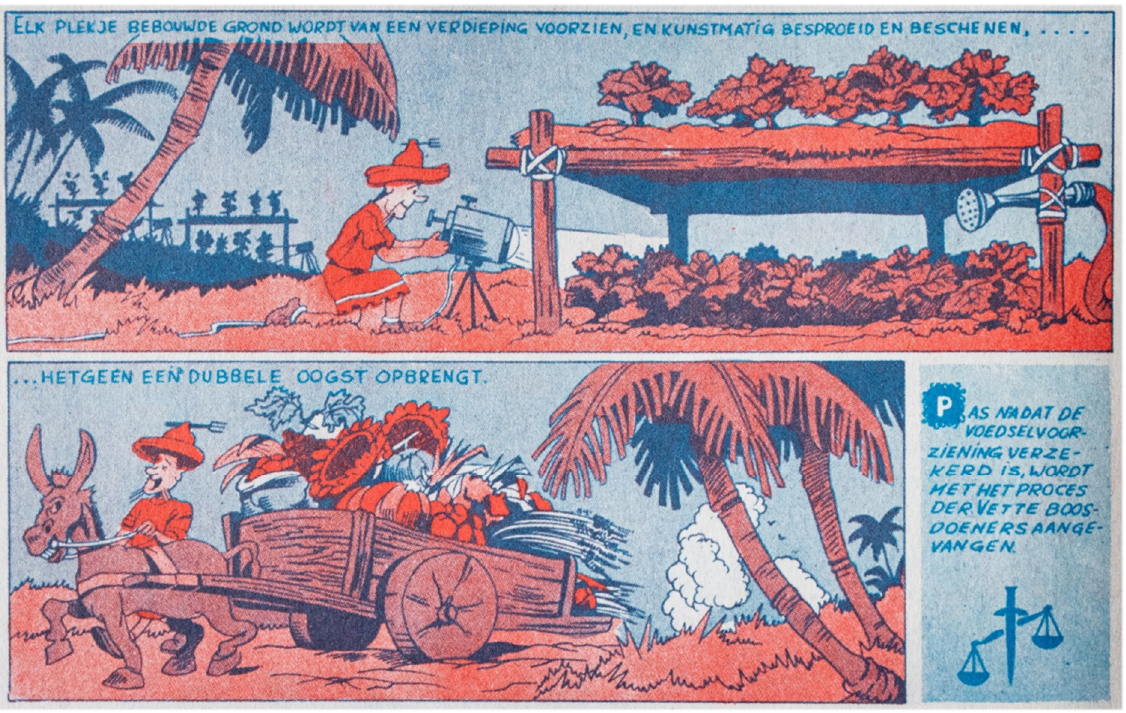
Figure 1. Two panels from the first Suske en Wiske (English: Spike and Suzy) comic strip Op het eiland Amoras by Willy Vandersteen depict a primitive vertical farm. The Belgian comic strip was published in De Nieuwe Standaard from 19, 1945 December to 13 May 1946. Its caption reads: “Every patch of cultivated land is storeyed and artificially watered and lit, yielding a double harvest.” With copyright permission from Standaard Uitgeverij [9].